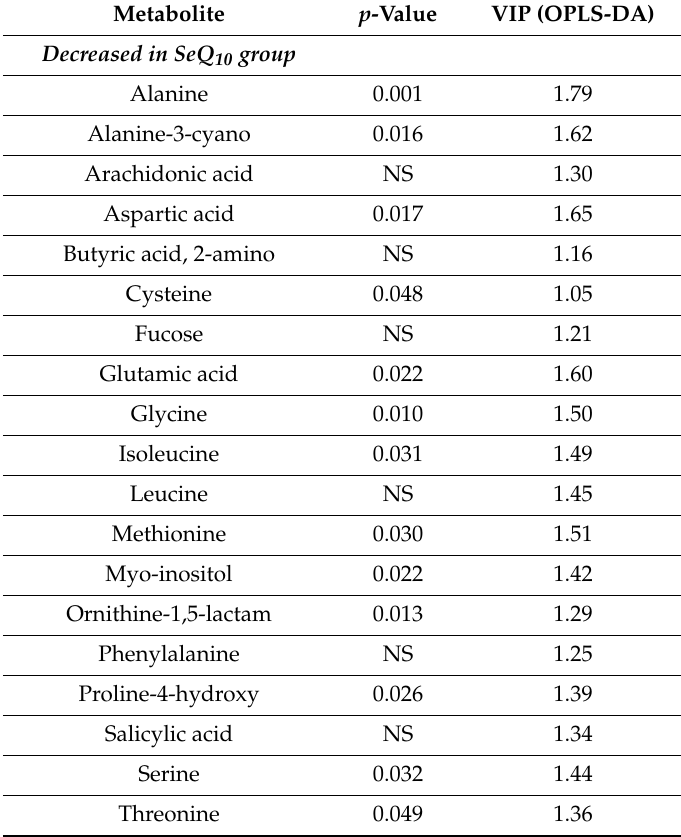
Table 2. Metabolites that showed significantly lower levels in plasma of men receiving a daily addition of SeQ 10 for 18 months as compared with the controls, the placebo-treated